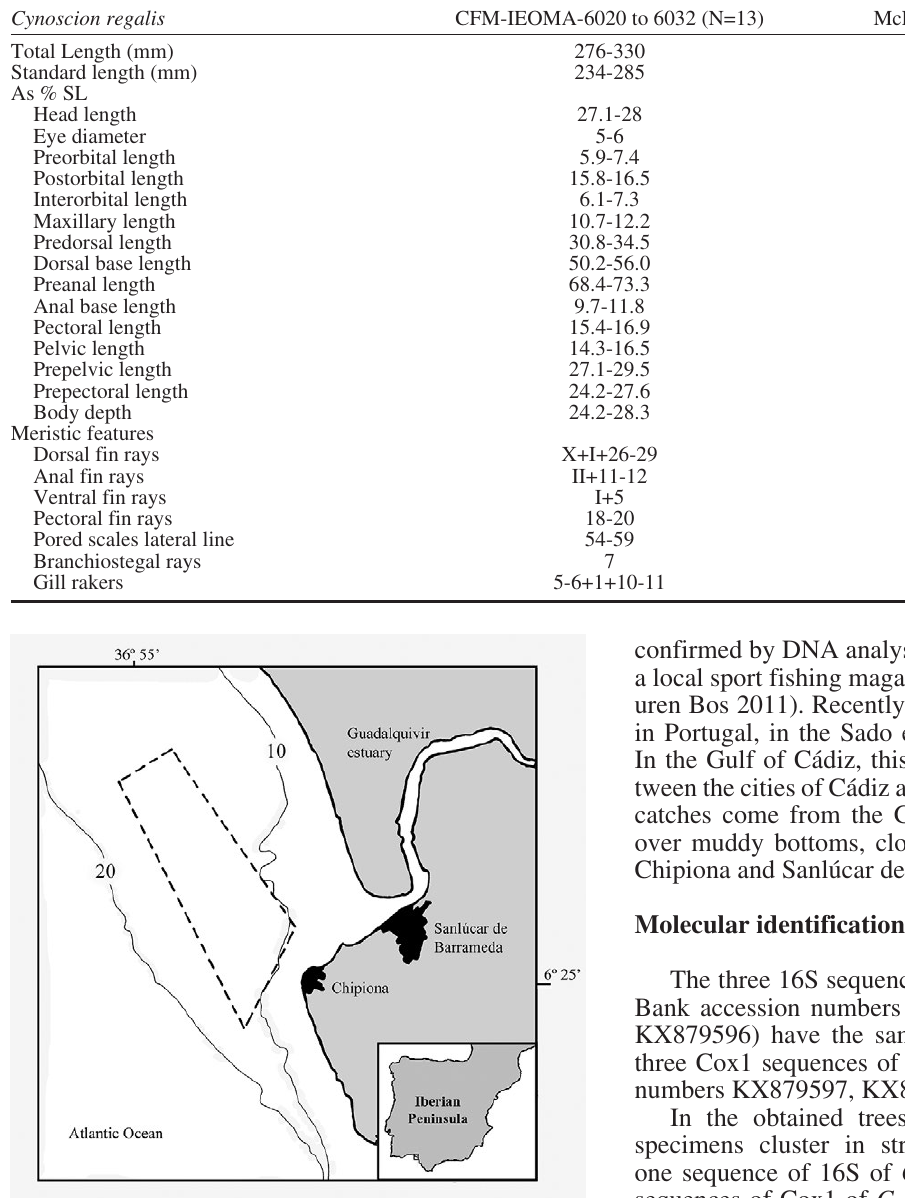
Table 1. – Comparison of morphometric, meristic data and respective body proportions for specimens of C. regalis .